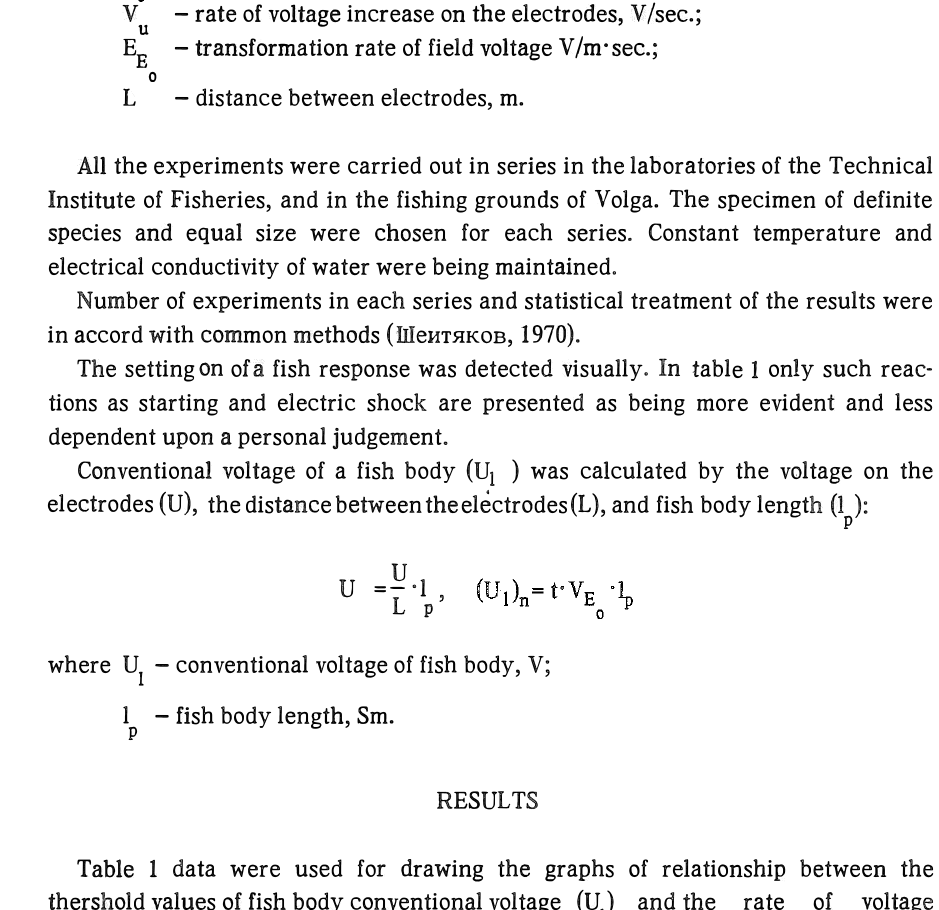
) and the rate of voltage transformation on the 1 n